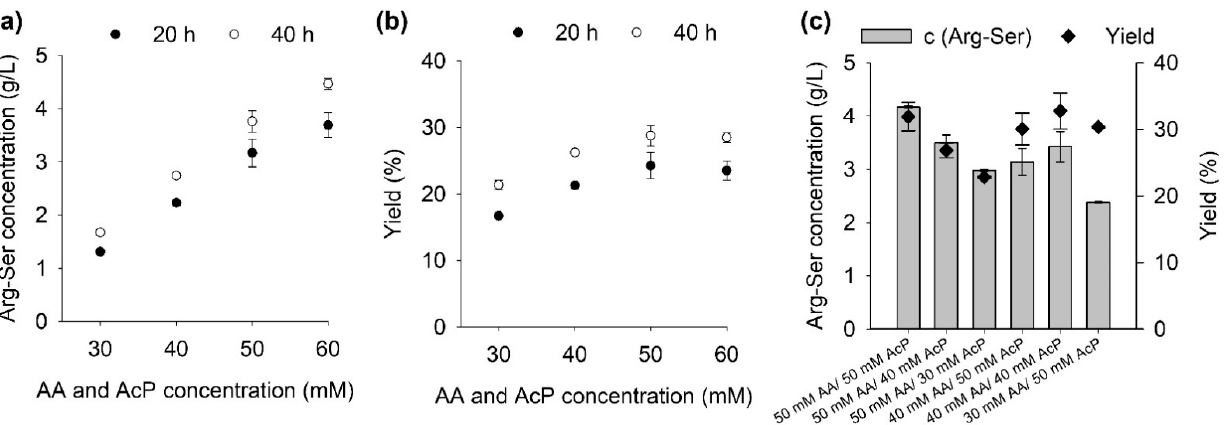
Figure 2. Effect of substrate amino acids (AA) and acetyl phosphate on the Arg-Ser production. All reactions were performed at 25 ◦ C. ( a ) Equimolar concentrations of amino acids and acetyl phosphate with 5 mM Mg 2+ . ( b ) Yields for data presented in ( a ). ( c ) Different ratios of amino acids to acetyl phosphate with 7.5 mM Mg 2+ and 20 h reaction time. Reactions were set up in duplicate; data are presented as mean with error bars representing